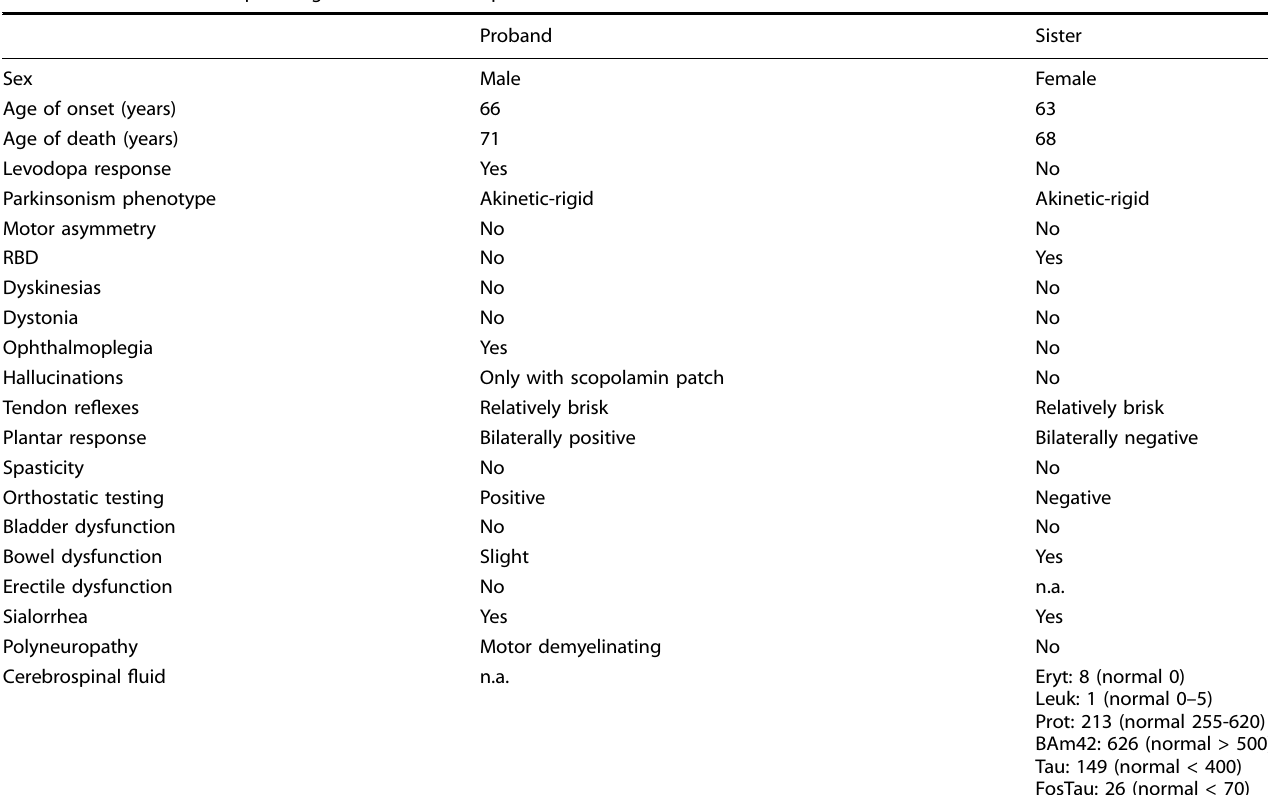
Table 1. Clinical and neuropathological features of the